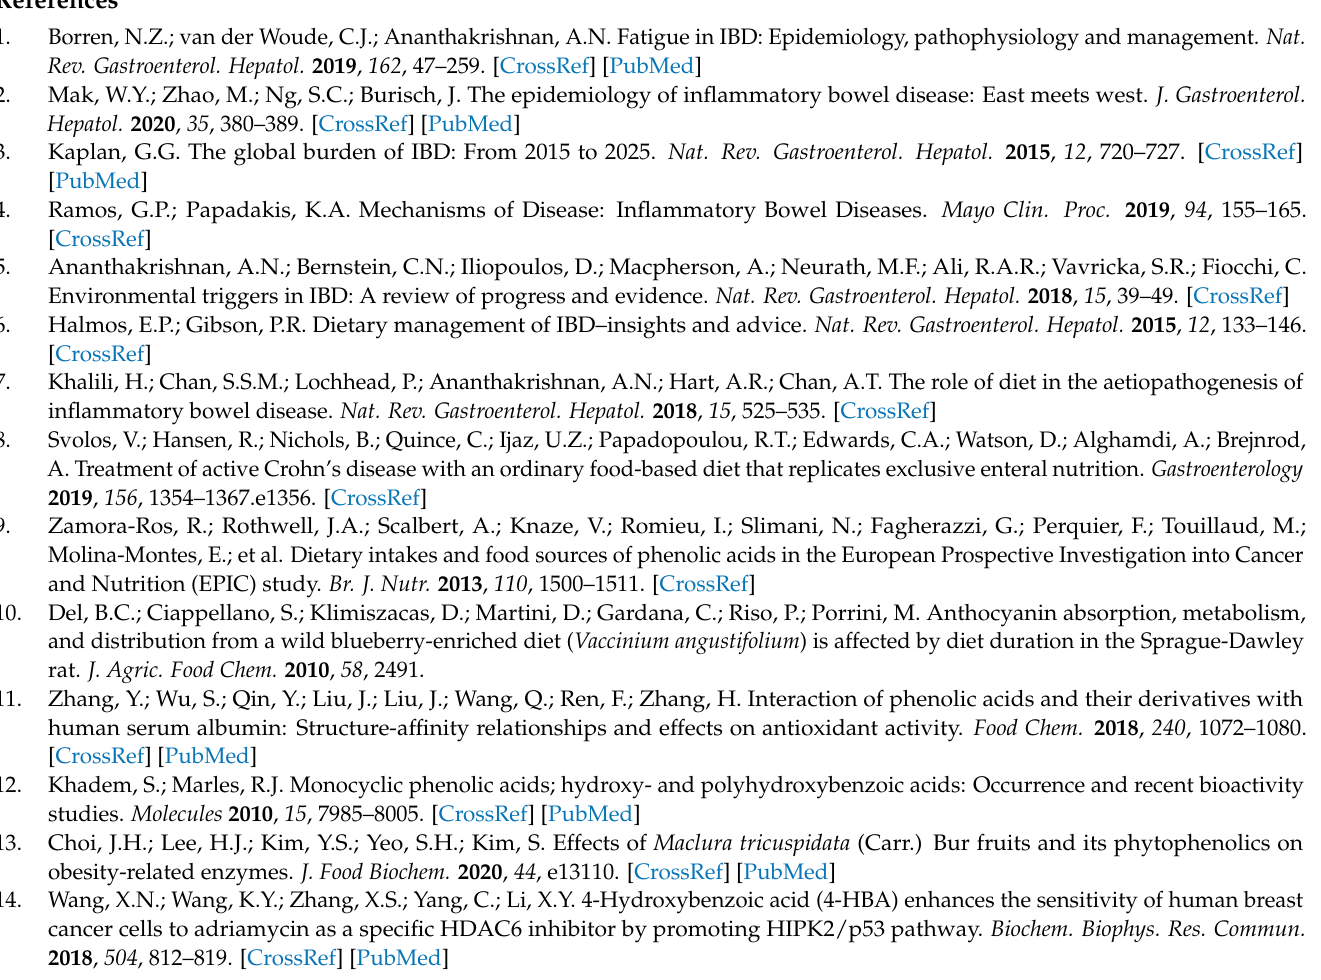
Figure S3: The effects of FMT from colitis mice treated with HA on inflammatory factors and immune cells; Table S1: The composition of the standard chow diet (per kg), Table S2: Primers